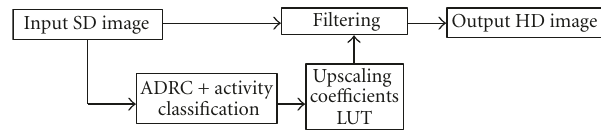
Figure 3: The filtering procedure of the proposed